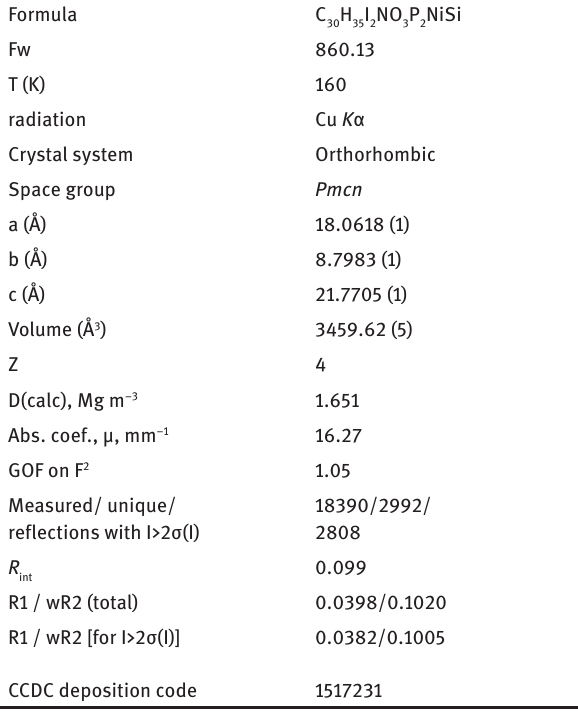
Table 1 : Crystallographic data of complex 1